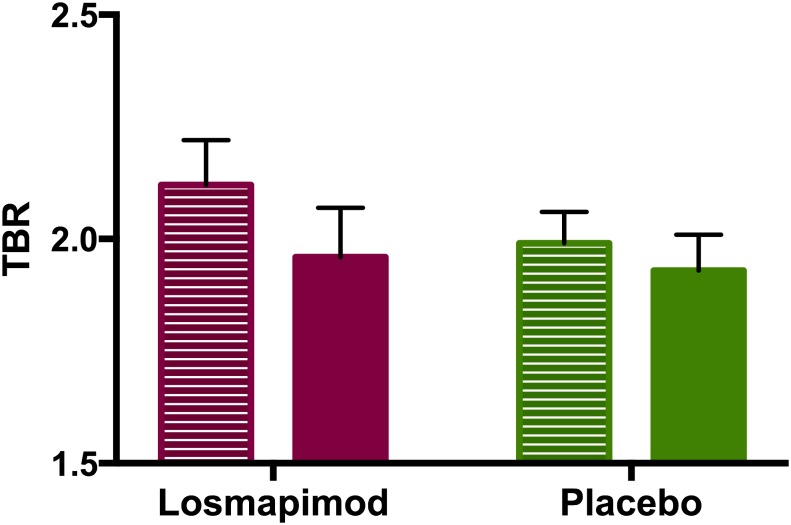
Tissue-to-blood ratio (TBR) at baseline and 16 weeks treatment with losmapimod or placebo in the index vessel.Losmapimod had no significant treatment effect, overall significance p = 0·42. Lined bars = baseline, solid bars at 16 weeks. Bars = mean values, error bars = 95% CI.